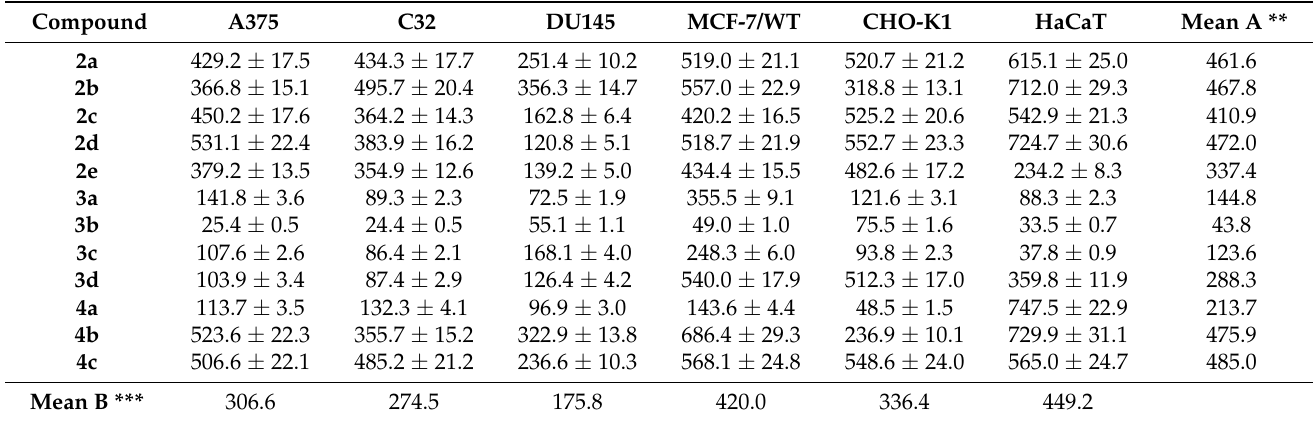
Table 2. The activity of 2a-2e , 3a-3d and 4a-4c compounds in cancer and normal cells, represented as IC 50 ( µ M) ± SD *.